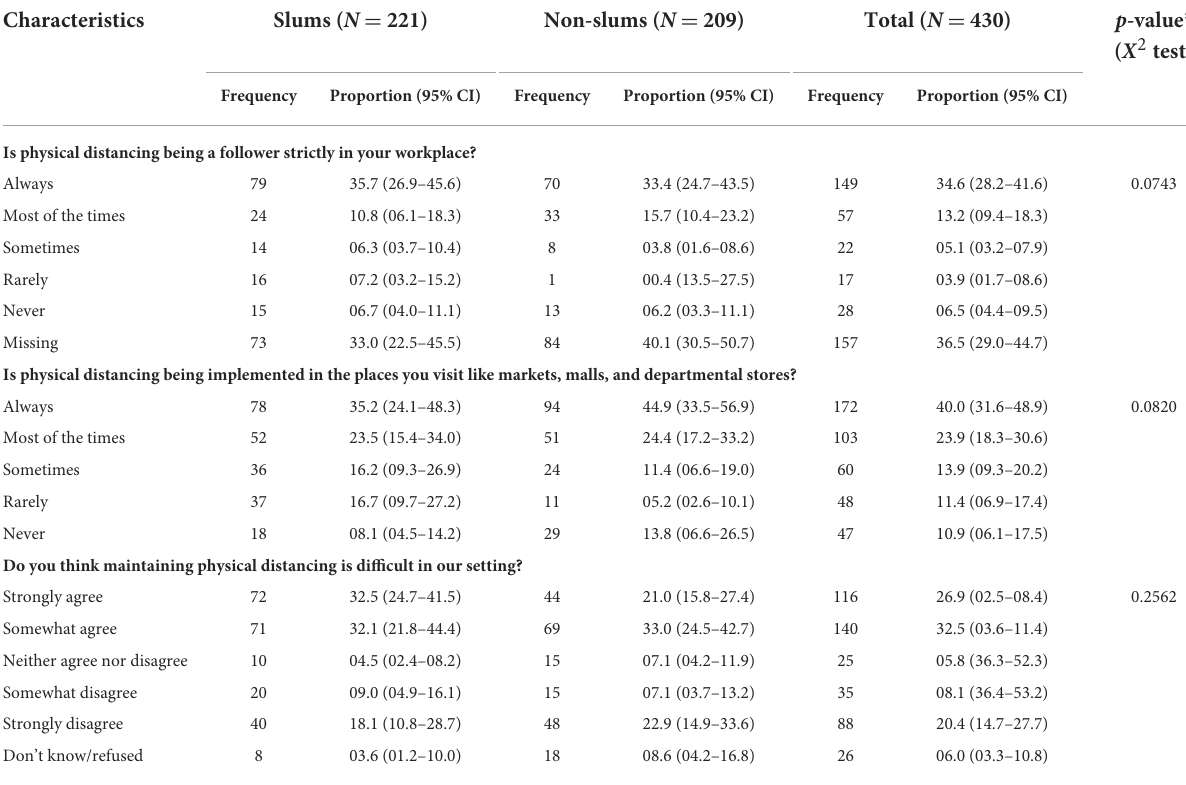
TABLE 6 Physical distancing practices among the slum and non-slum population, Greater Chennai Corporation, India, March 2021 ( N = 430).